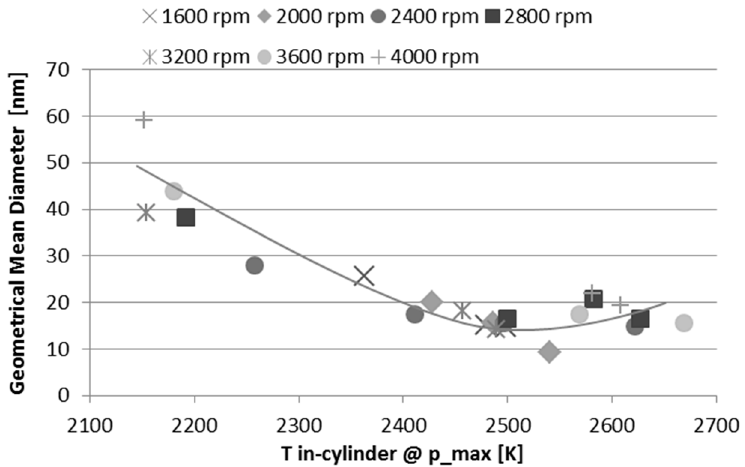
Figure 8. GMD as a function of modelled gas temperature at the location of peak pressure.